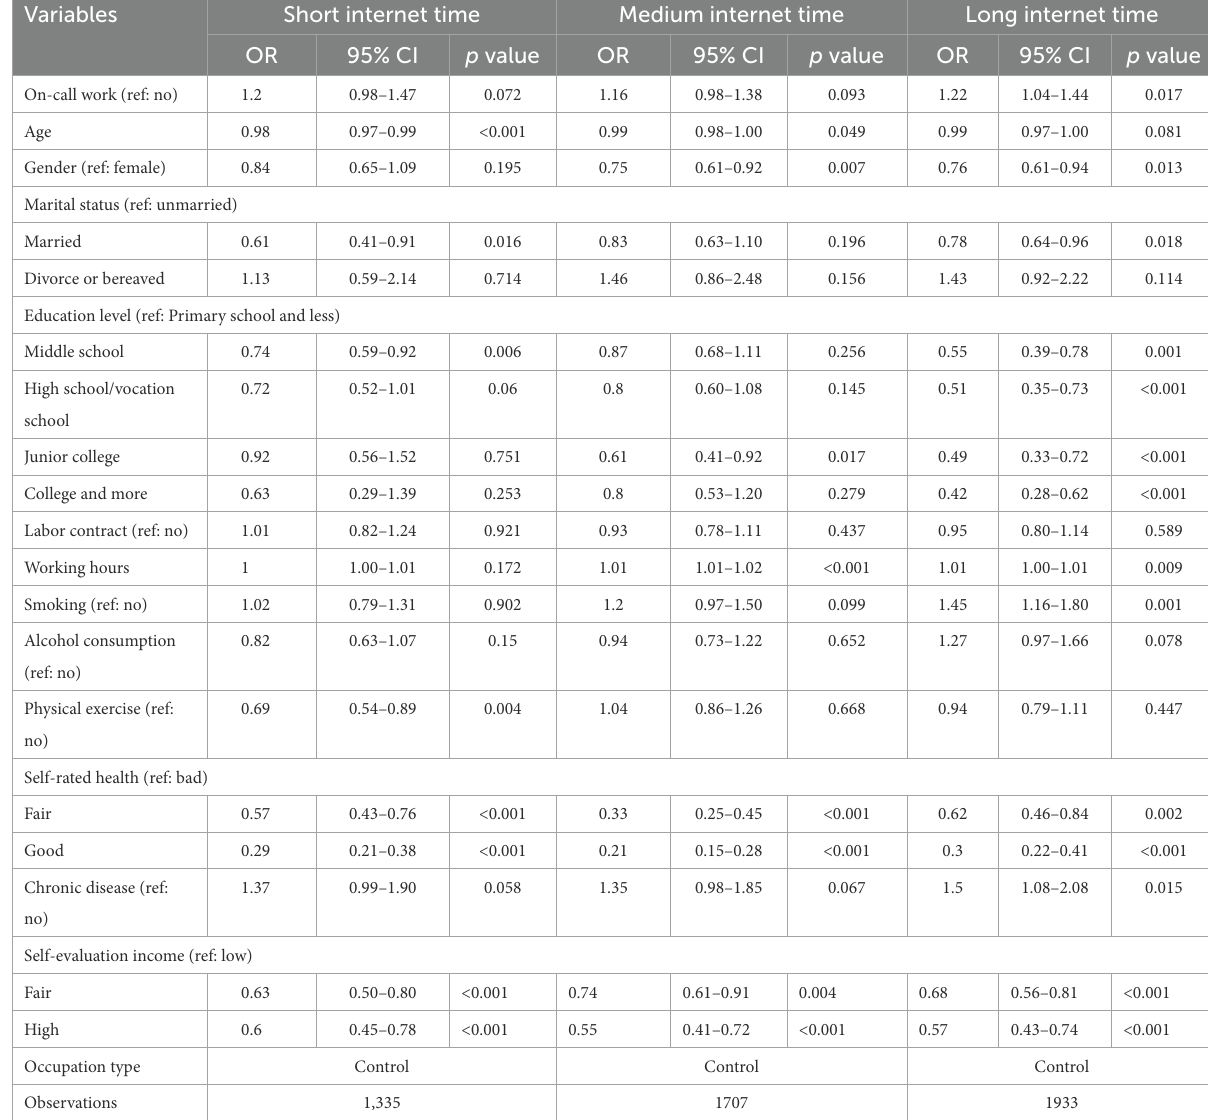
TABLE 6 Associations between on-call work and depressive mood, grouped by internet